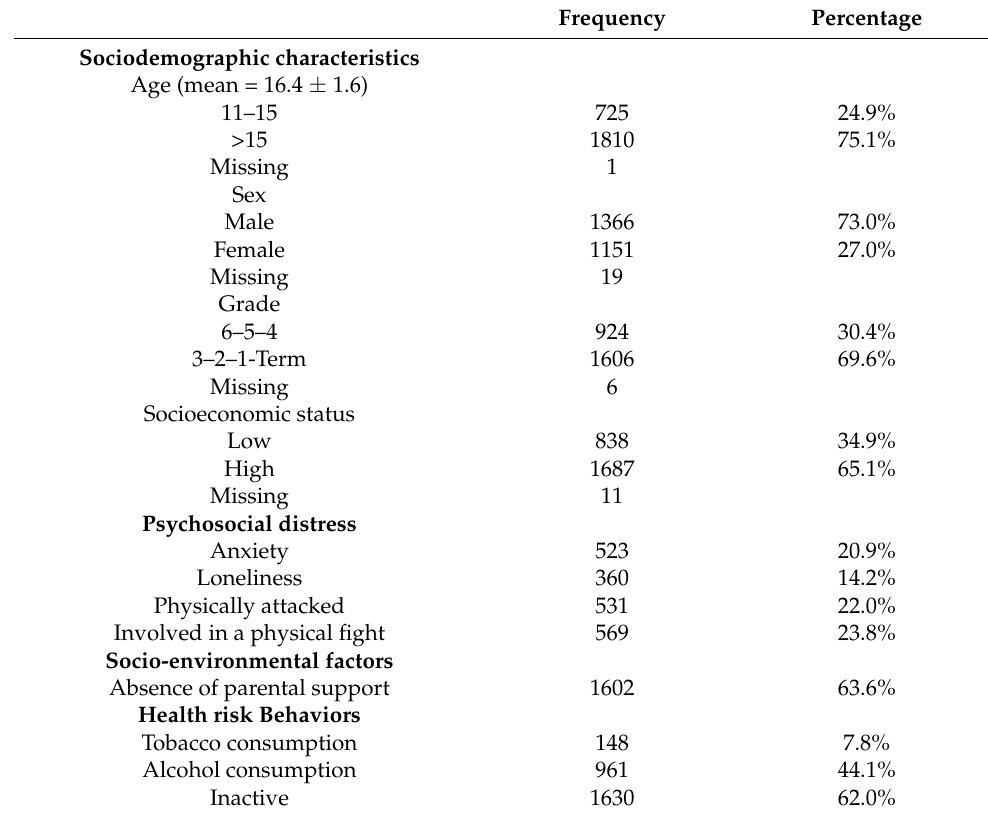
Table 2. Sociodemographic characteristics and health-related lifestyle habits of adolescents aged 11–18 in Benin,